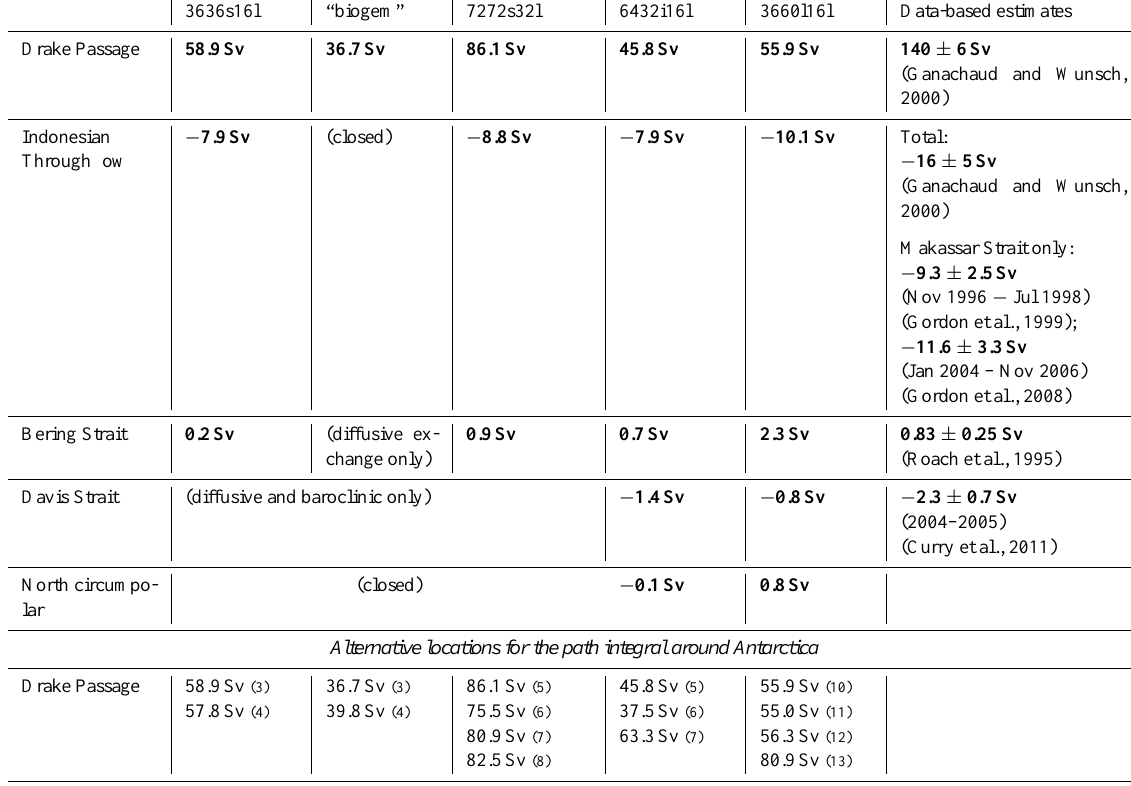
Table 4. Annual-mean net transport through straits (positive transport is directed northward or westward) simulated by the five configurations and data-based estimates. The last row lists the net transport through the Drake Passage simulated with configurations where the location for the path integral around Antarctica was varied among all permissible straight paths (the value in parentheses indicates the grid row for this path on the respective